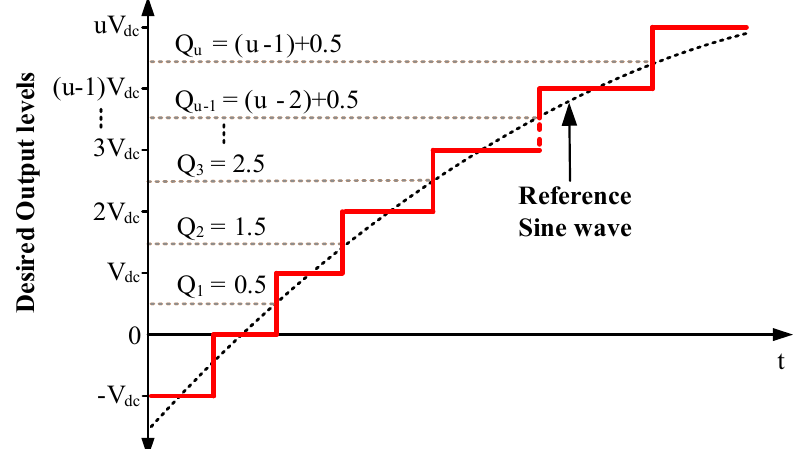
Figure 50. Sampled reference signal [93].